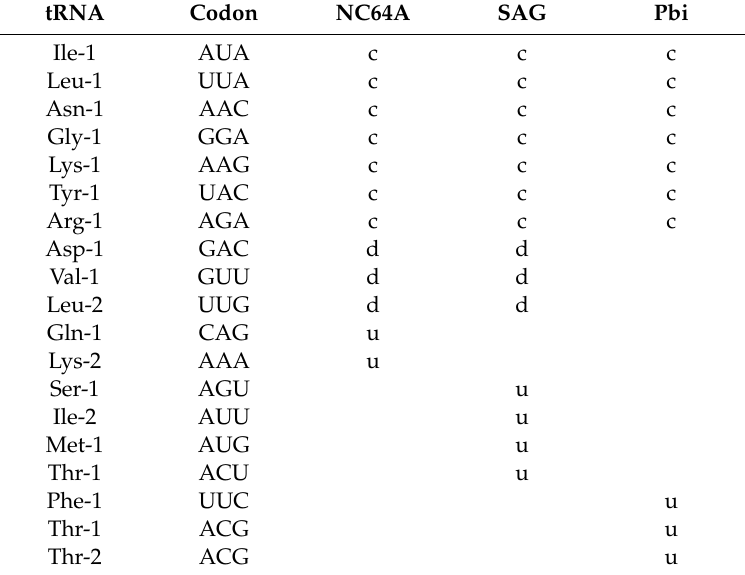
Table 4. Chlorovirus tRNA genes common to one another and unique to each chlorovirus clade 1 . tRNA Codon NC64A SAG Pbi